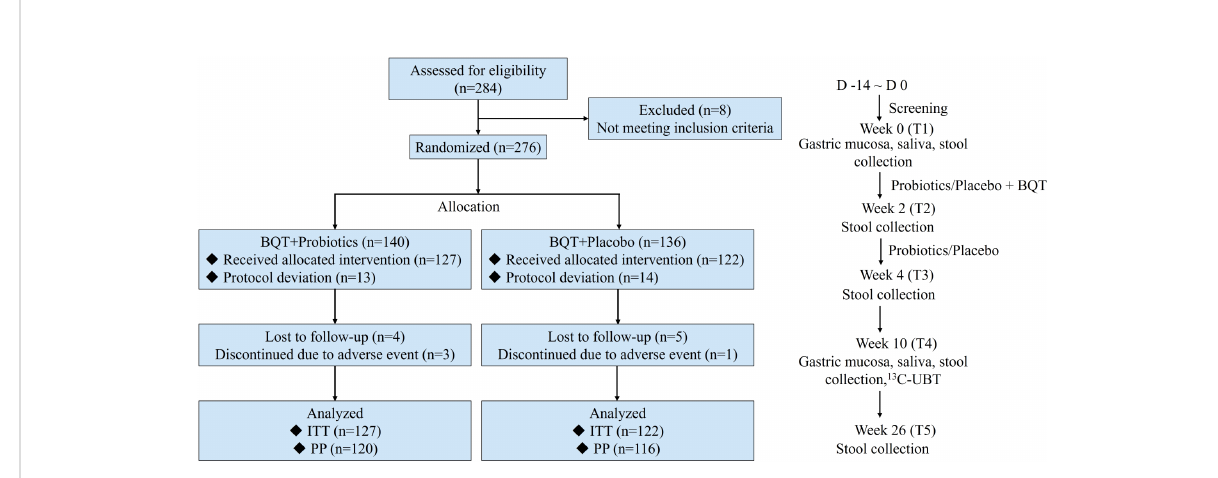
FIGURE 1 Flow diagram showing the study design. BQT, bismuth quadruple therapy; ITT, intention-to-treat; PP, per protocol; D, day; 13 C-UBT, 13 C-Urea Breath